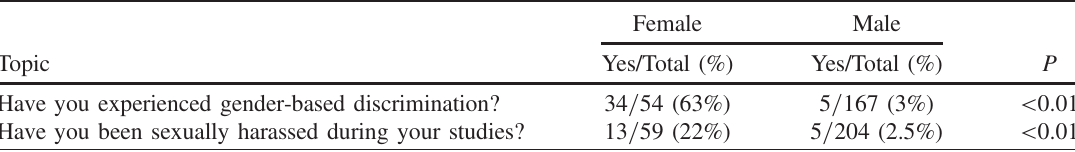
TABLE II. Results of survey on the issues of gender-based discrimination and sexual harassment.